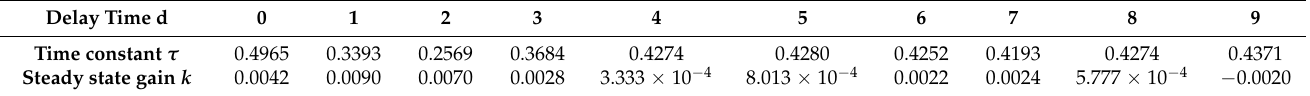
Table 5. Identification results of τ and k for depth loop with different delay time parameter d.